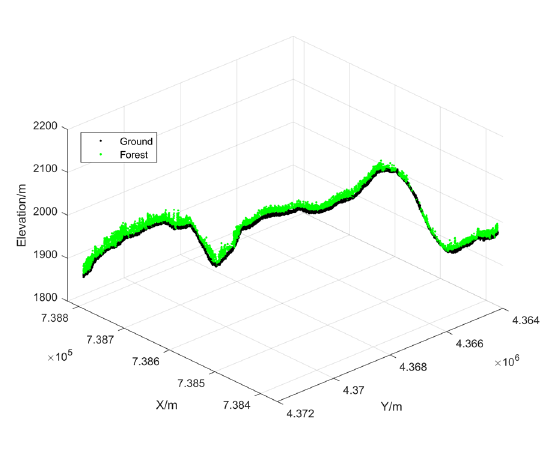
Figure 11 . Reference signal photons data.